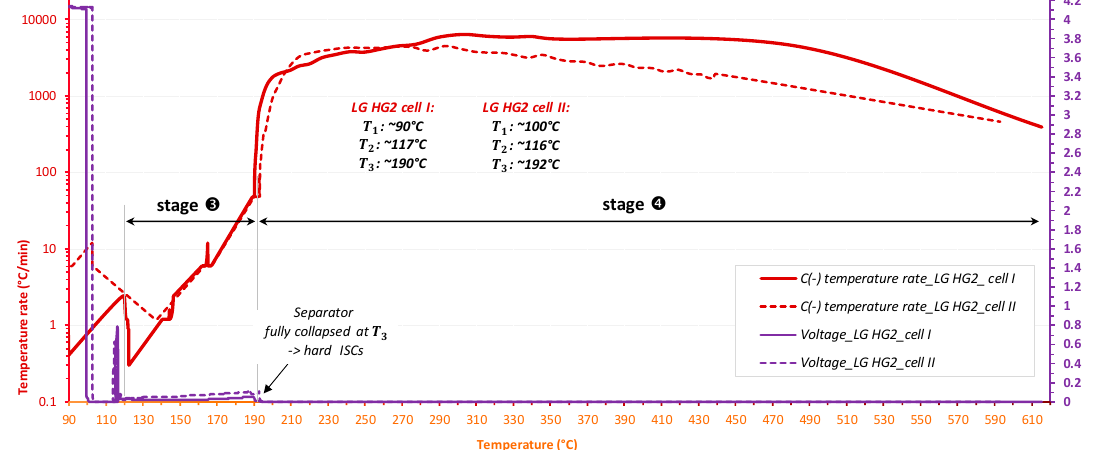
Figure A1. Reproducible HWS test results of 2 LG HG2 pristine cells at 100% SOC.